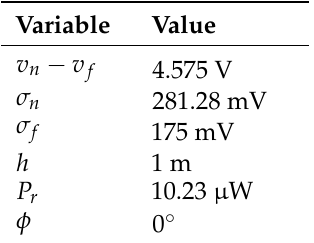
Table 4. Experimental data for receiver noise